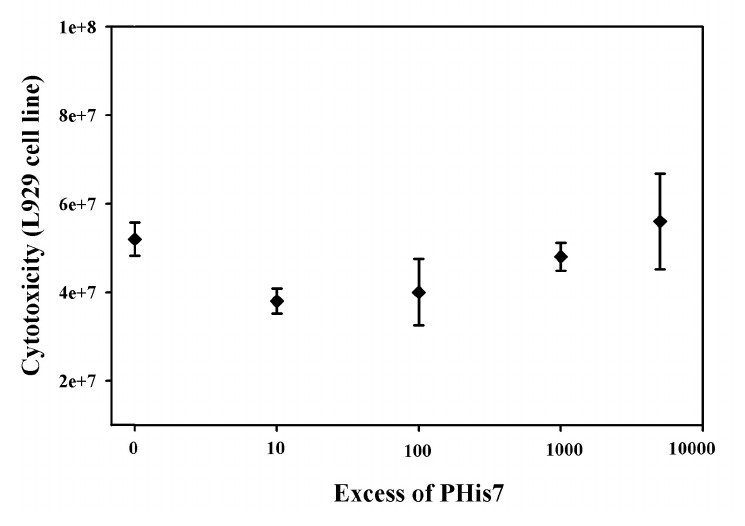
FIGURE 4 . Influence of excess PHis7 peptide on